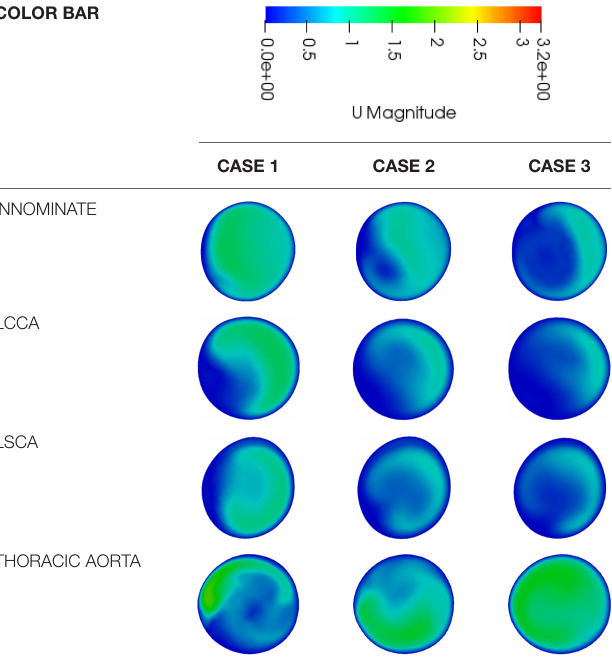
TABLE 4 | A qualitative comparison of the velocity magnitude contours between the different repair cases at each major outlet. COLOR